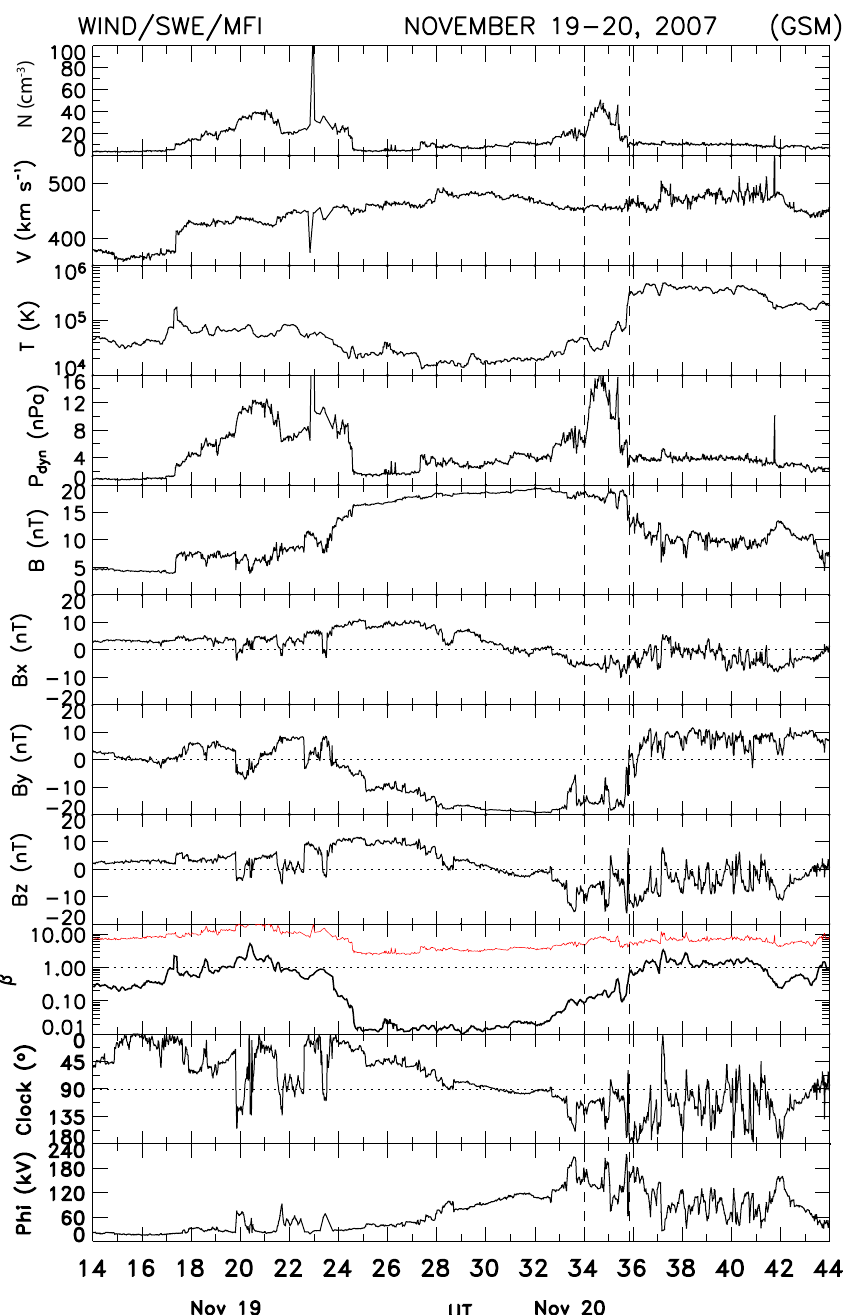
Fig. 13. Wind data for the interval 14:00UT, 19 November–20:00UT, 20 November 2007. The Wind interval (10:00–11:50UT, 20 Novem- ber) corresponding to the low-altitude observations discussed in this paper is marked by vertical guidelines. Same format as in Fig.